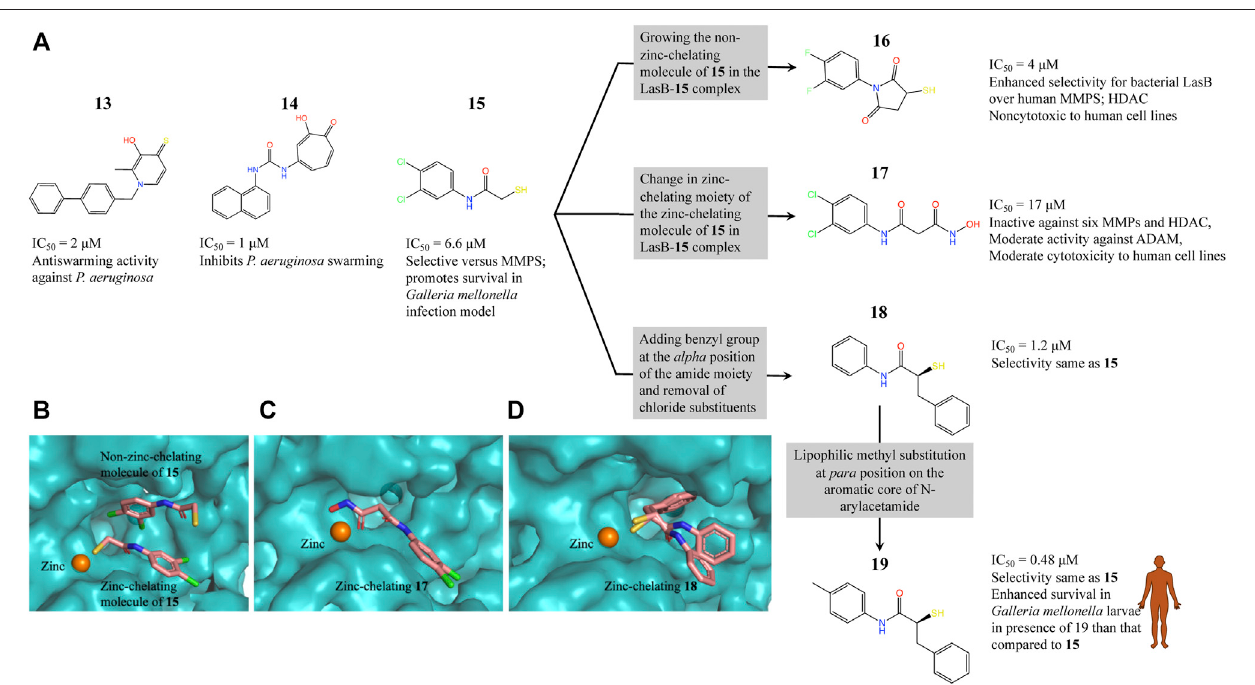
FIGURE 4 | (A) Inhibitors developed using FBDD against Pa LasB with IC 50 values in the low micromolar range. Compounds 16 , 17 and 18 were developed using three different strategies guided by the crystallographic complex of Pa LasB with 15 (B) . Compound 19 with best IC 50 value was obtained from compound 18 by substitution of a hydrophobic group guided by the structure of Pa LasB- 18 complex (pdb id 7oc7, unreleased) (Kaya et al., 2021). (B) Locations of compound 15 in Pa LasB- 15 complex (pdb id 6f8b) determined by X-ray crystallography (Kany et al., 2018a). Two molecules of compound 15 bind in the active site of Pa LasB, one ofwhich coordinates withtheactive sitezinc ion. (C) Pa LasB- 17 complex(pdb id6fzx)withonly onemolecule ofcompound 17 binding andcoordinating withzincionof Pa LasB (Kany et al., 2018b). (D) Pa LasB- 18 complex (pdb id 7oc7, unreleased) with two conformers of a single molecule of 18 . The inhibitors are shown as sticks and zinc ions as orange spheres in (A) , (B) and (C) . The coordinates for the unreleased pdb 7oc7 was kindly provided by Prof. Dr. Anna K. H.